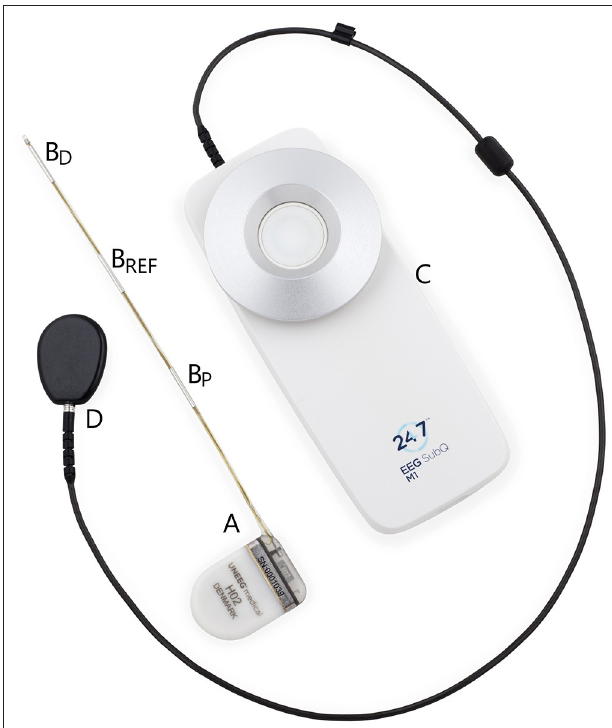
FIGURE 1 | The two physical parts of the discussed ultra long-term subcutaneous EEG recorder. The implantable part (A) is placed extracranially underneath the skin. It measures bipolar EEG from the contact points (B D -B REF and B P -B REF ) with the center electrode as the reference and an interelectrode distance of 3.5cm. The external part (C) is attached to the clothes of the person with epilepsy and the disk (D) is attached to the skin aligned with the housing of the implant (A). As soon as the external disk and the implant housing are aligned, EEG is recorded and